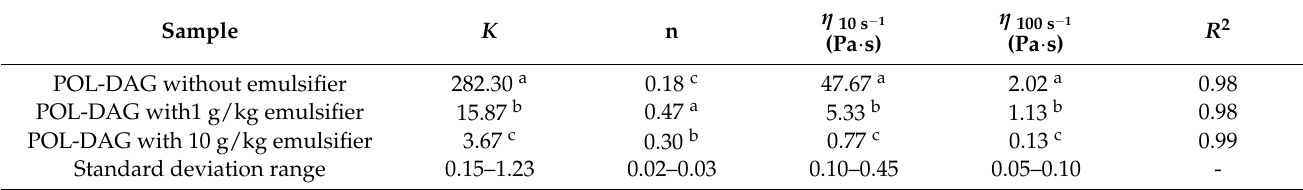
Table 3. Flow curves parameters of palm olein-based diacylglycerol (POL-DAG) oil with and without emulsifier.